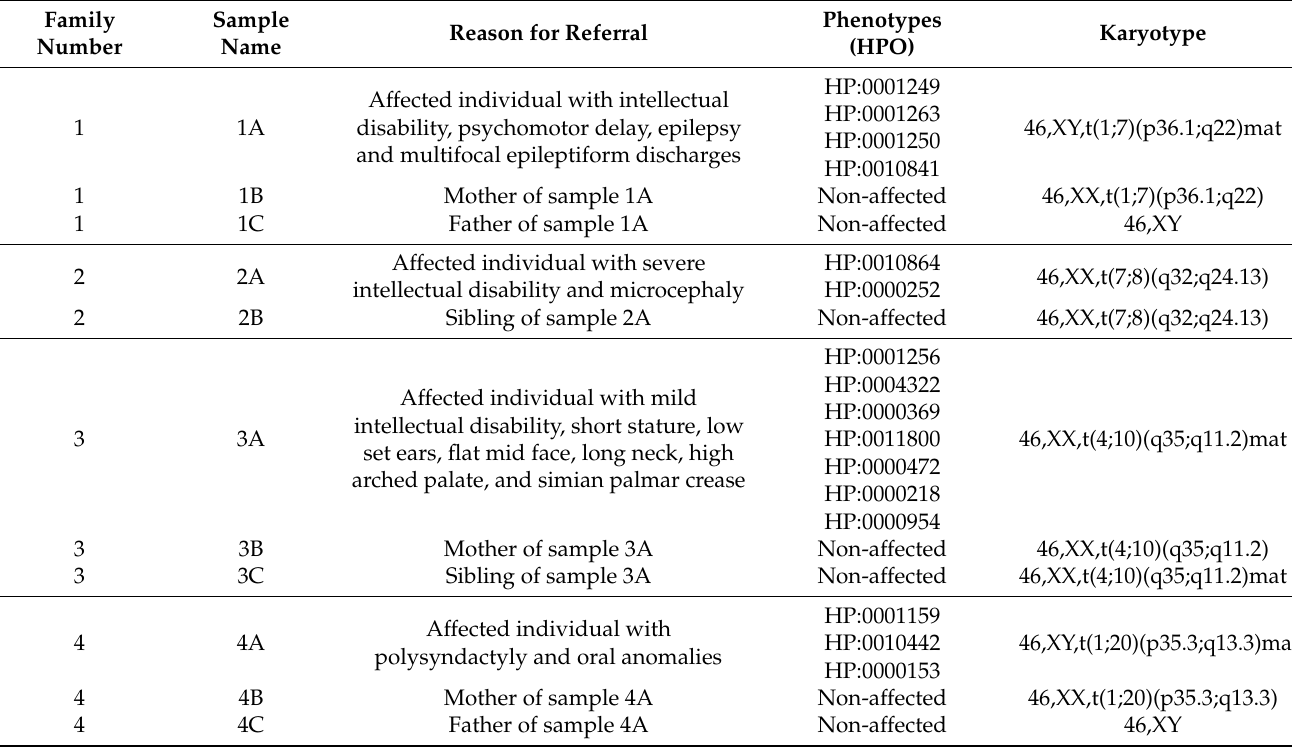
Table 1. List of families/samples included in the present